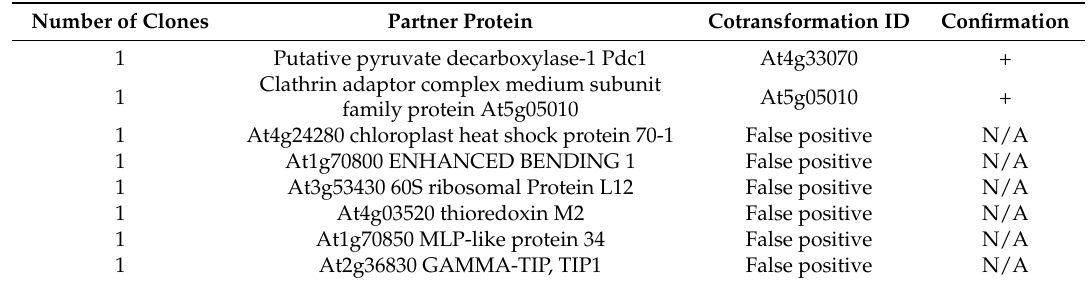
Table 3. Partner proteins of CYP57M selected in the process of Y2H screening. “+” shows true interaction.